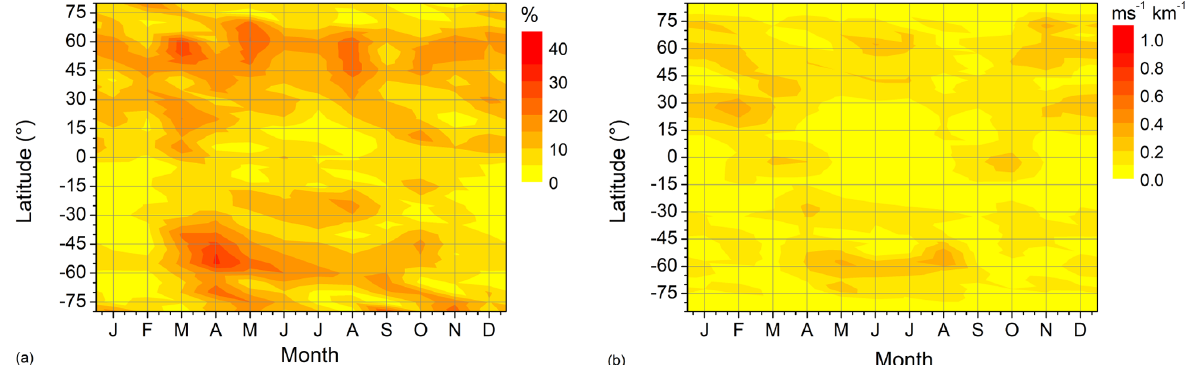
Figure A5. As in Fig. A4, but showing Es relative amplitudes at 107km and zonal wind shear at 106 . 6km.